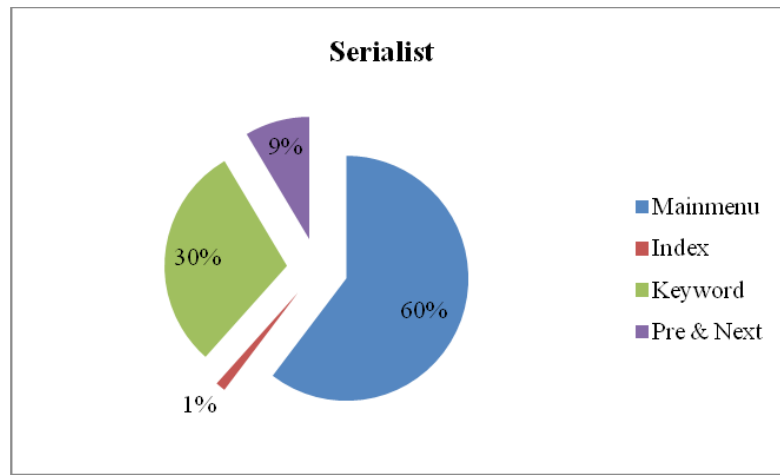
Figure 3. The tools used by